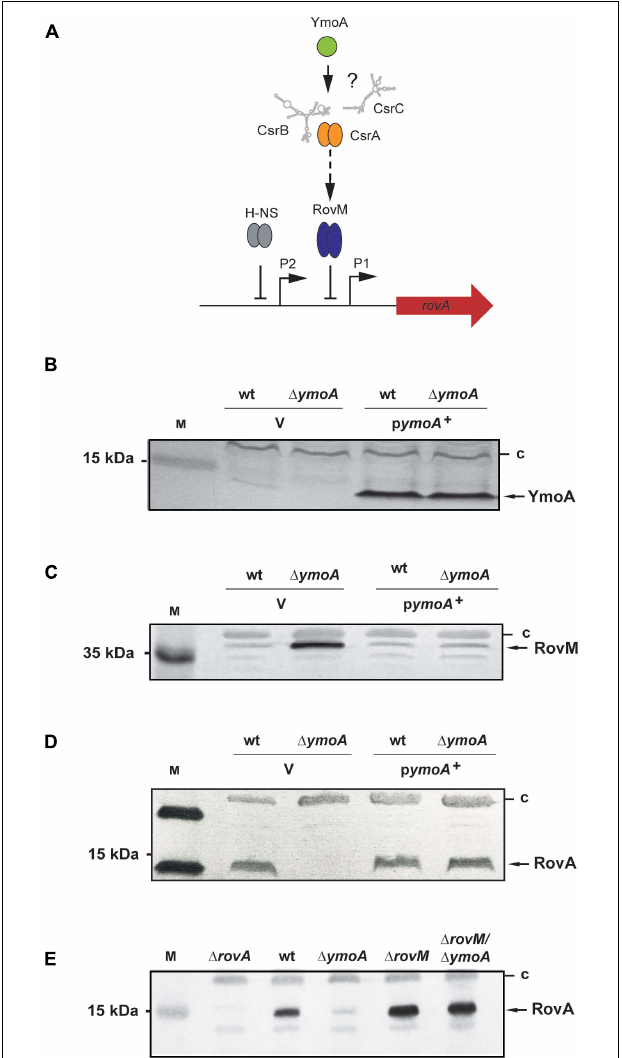
FIGURE 2 | Analysis of RovA and RovM levels in Y. pseudotuberculosis in the presence or absence of YmoA. (A) Regulatory components controlling rovA expression in Y. pseudotuberculosis are illustrated and assumed influence of YmoA on the regulatory cascade is indicated by ‘?’. (B–D) Whole-cell extracts from overnight cultures of Y. pseudotuberculosis wild-type and mutant strain YP50 ( (cid:49) ymoA ) transformed with pACYC184 (V) or pAKH71 ( ymoA + ) grown at 25 ◦ C were prepared and analyzed by Western blotting with a polyclonal antibody directed against YmoA (B) , RovM (C) , and RovA (D) . A molecular weight marker is loaded on the left. (E) Whole-cell extracts from overnight cultures of the Y. pseudotuberculosis wild-type (YPIII), and the rovA (YP3), ymoA (YP50), rovM (YP41), and rovM/ymoA (YP73) mutant strains were prepared. RovA in the extracts were detected by Western blotting using polyclonal antibodies directed against these proteins. A prestained molecular weight marker is loaded on the left. Unspecifically detected proteins (c) were used as loading